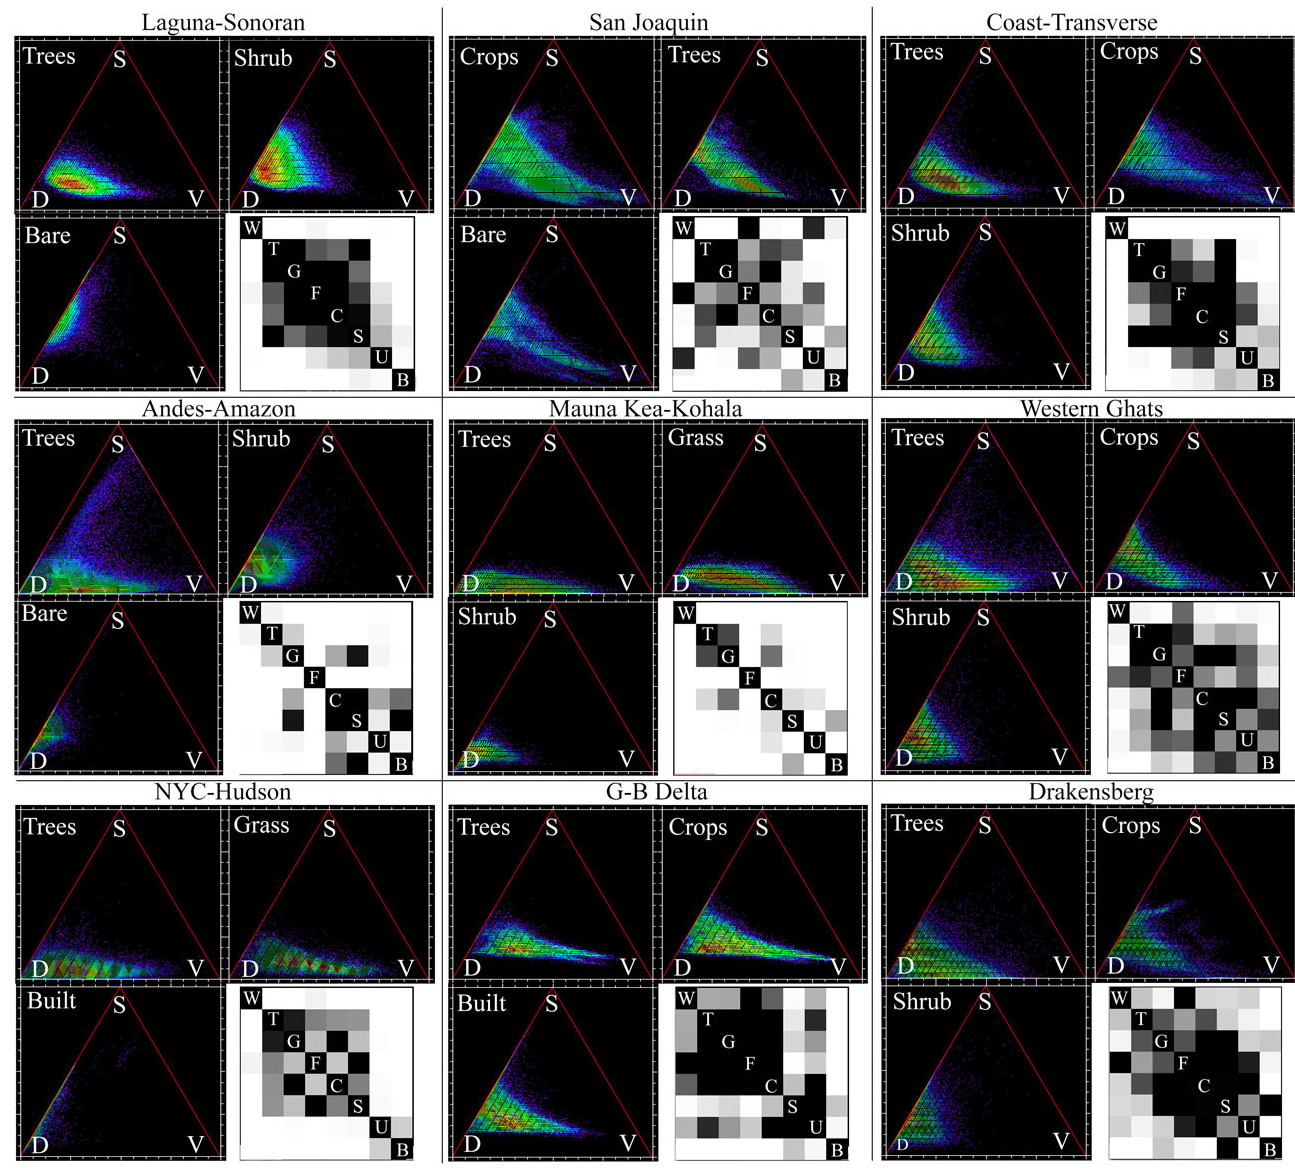
Figure 6. Land cover class SVD fraction distributions and spectral separability matrices for nine spectral diversity hotspots. Trivariate distributions in ternary diagrams all show spectral mixing continua tapering from a range of substrate albedos to increasing vegetation fraction. Most are displaced toward the dark endmember because of shadow and soil moisture darkening. Spectral separability of class pairs, quantified as transformed divergence of reflectance spectra distributions of each class pair, is displayed in spectral separability matrices with a linear stretch between 1.5 (black) and 2.0 (white). Class pairs with lighter shades are more spectrally separable within the corresponding hotspot. For example, the Built (U), Bare (B), and Water (W) classes are much more separable than the other classes in the NYC-Hudson and Laguna-Sonoran hotspots, while only the Tree (T), Grass (G), and Crop (C) classes show low separability for the Mauna Kea–Kohala hotspot. In hotspots where both occur, water (W) and flooded vegetation (F) have low separability. Density-shading of the SVD ternaries uses the same cool to warm color table as Figures 2 and